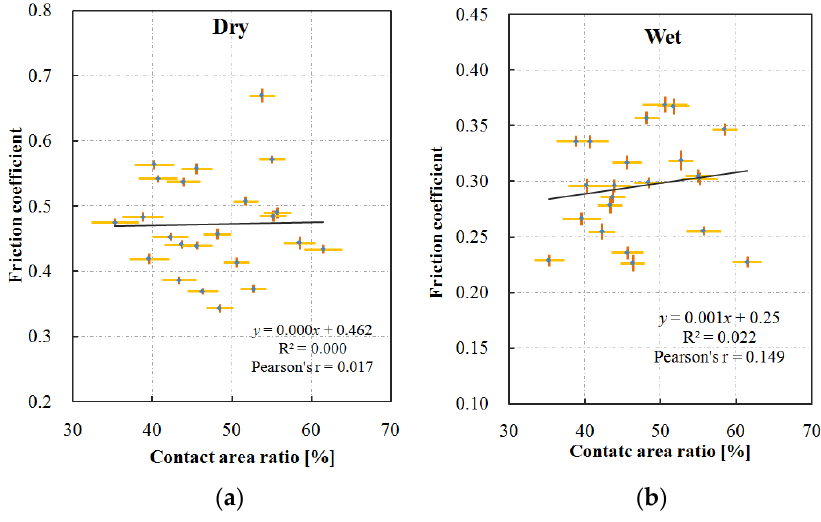
Figure 13. Effect of contact area on friction coefficient measured under ( a ) dry and ( b ) wet conditions.